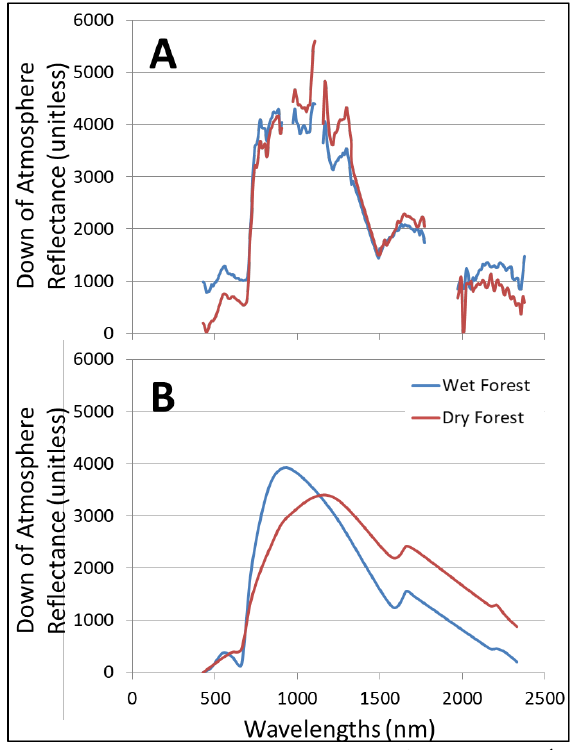
Figure 4. WorldView-3 spectral signatures of the 10 classes (A: 8 marine, B: 2 terrestrial). 16 bands were operable Overall, Hyperion DOA reflectance was higher than WV3 one, and classes seemed more contrasted for Hyperion NIR and SWIR. Common spectral patterns were constant in the VIS spectrum: highest reflectance for shallow channel, followed by deep channel, pavement with reef, barrier reef, shallow outer reef, deep outer reef. However, Fringing reef, deep ocean and dry forest appeared brighter, relatively to other classes, for Hyperion compared to WV3. Discrepancies between both sensors might be explained by the spatial Hyperion information, based on a single 30-m pixel (Table 2), over-reflecting water classes within absorbing NIR and SWIR, due to sun glint integration in the coarse pixel. Results of the ANN modelling, classifying the 10 classes based on combinations of Hyperion and WV3 spectral wavebands, were significant (Figure 5). RGB (3 bands), RGBNIR (4 bands), RGB-Coastal-yellow (5 bands) and RGBNIRs (8 bands) classifications showed greater performances for Hyperion than WV3 (0.06 difference in R 2 ). The combination, including 16 WV3 bands, and corresponding 16 Hyperion bands, was still better for Hyperion, but with a reduction in deviation (0.04 difference in R 2 ), due to the rise trend of WV3 and a slight decrease of Hyperion. The latter sensor’s score further declined when all 167 bands were integrated into ANN modelling, making the 16-band WV3 combination a better predictor than Hyperion. Hyperion counter-performance might be justified by the spectro-statistical noise conveyed by too many bands, thus the need for dimensionality reduction (Keller et al.,